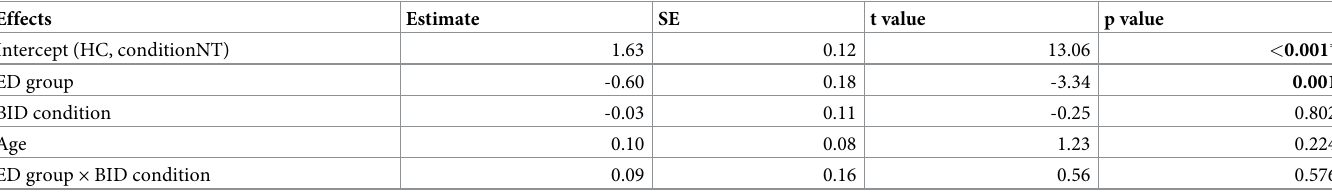
Table 10. Mixed effects linear regression analysis of inverse temperature parameter β 2